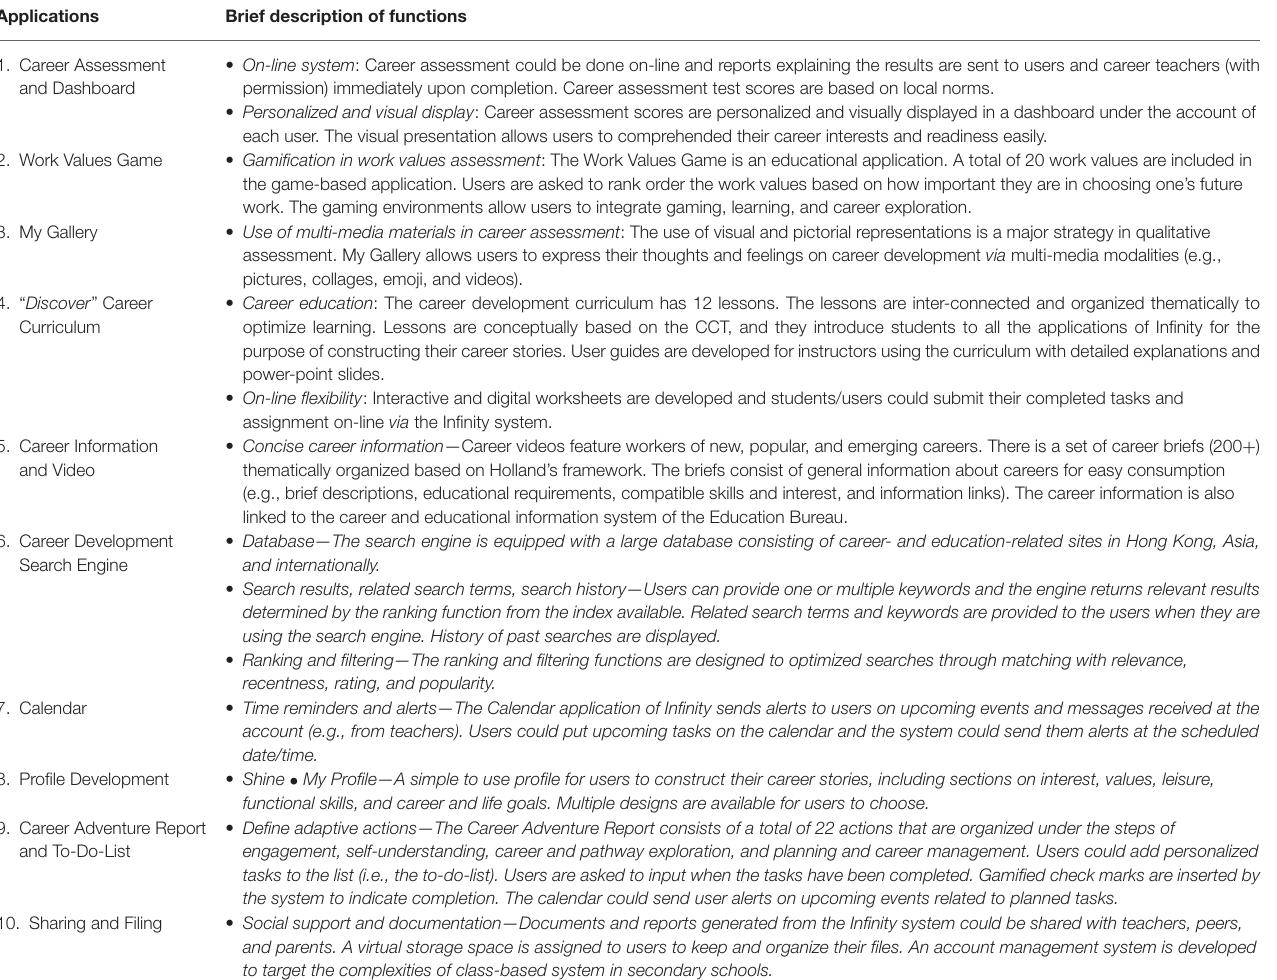
TABLE 1 | Applications and functions of the infinity